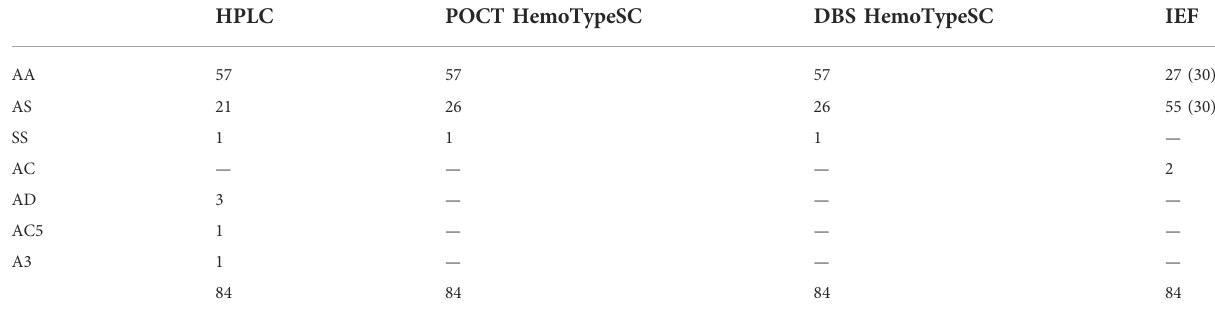
TABLE 2 Showing the results of the 84 discordant samples run with HPLC.